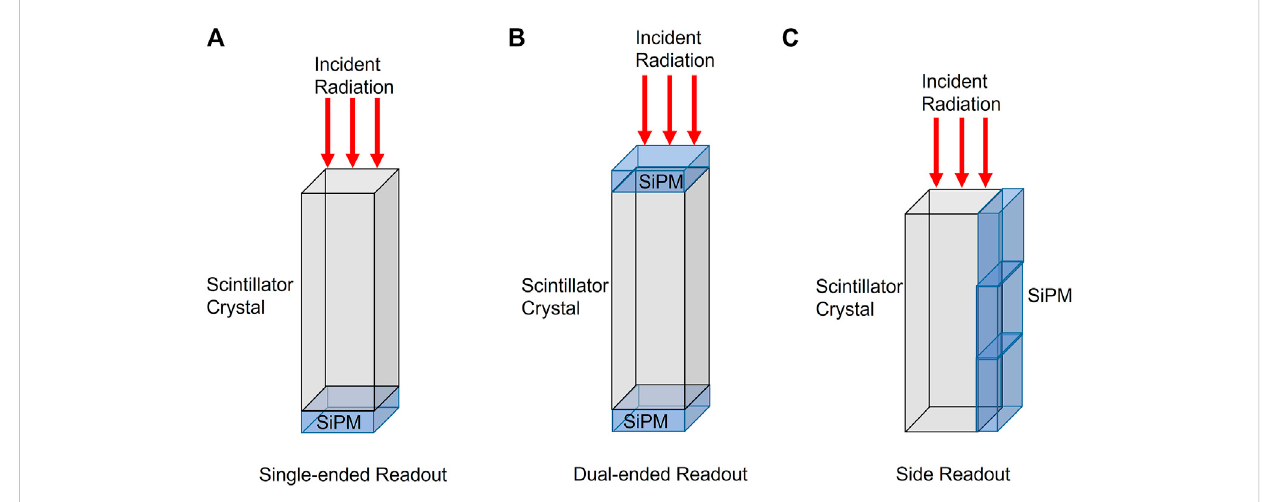
FIGURE 3 Different con fi gurations for PET detector photosensor coupling. (A) Single-ended readout, (B) Dual-ended readout, (C) Side